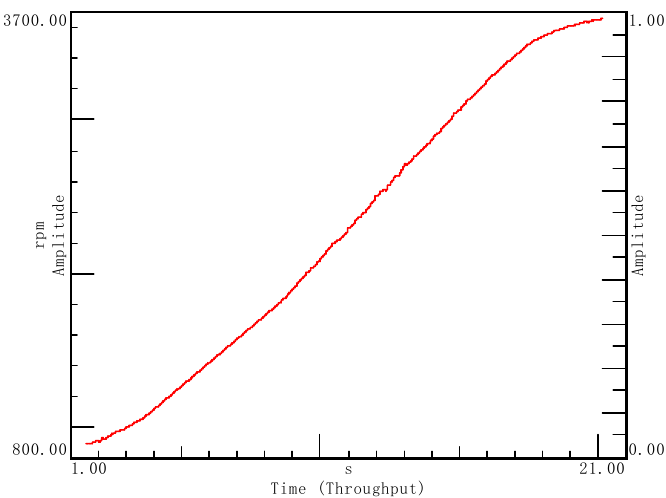
Figure 5. Engine speed variation curve during in-vehicle noise